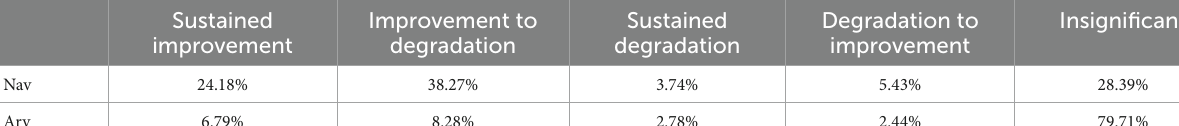
TABLE 4 Table of future trends of vegetation in the NAR, 2001–2018.